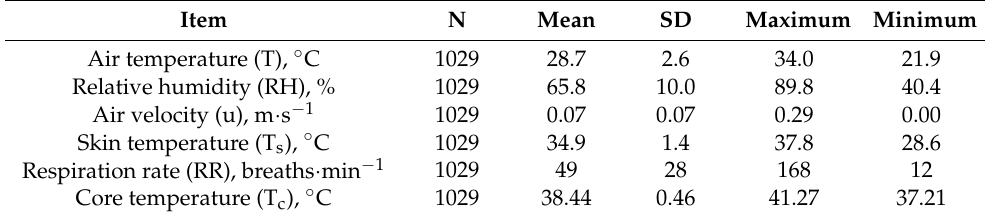
Table 1. Statistics of the integrated dataset. N represents the total amount of data. SD represents the standard deviation of the